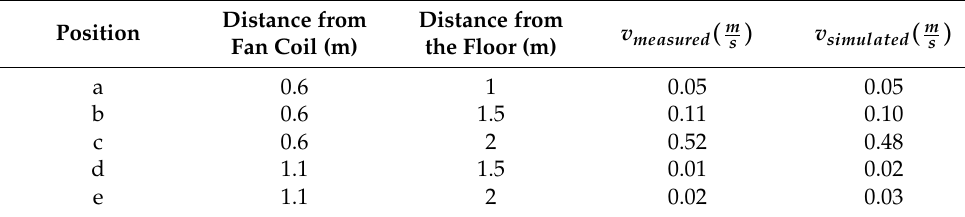
Table 3. Comparison of measured and simulated velocity